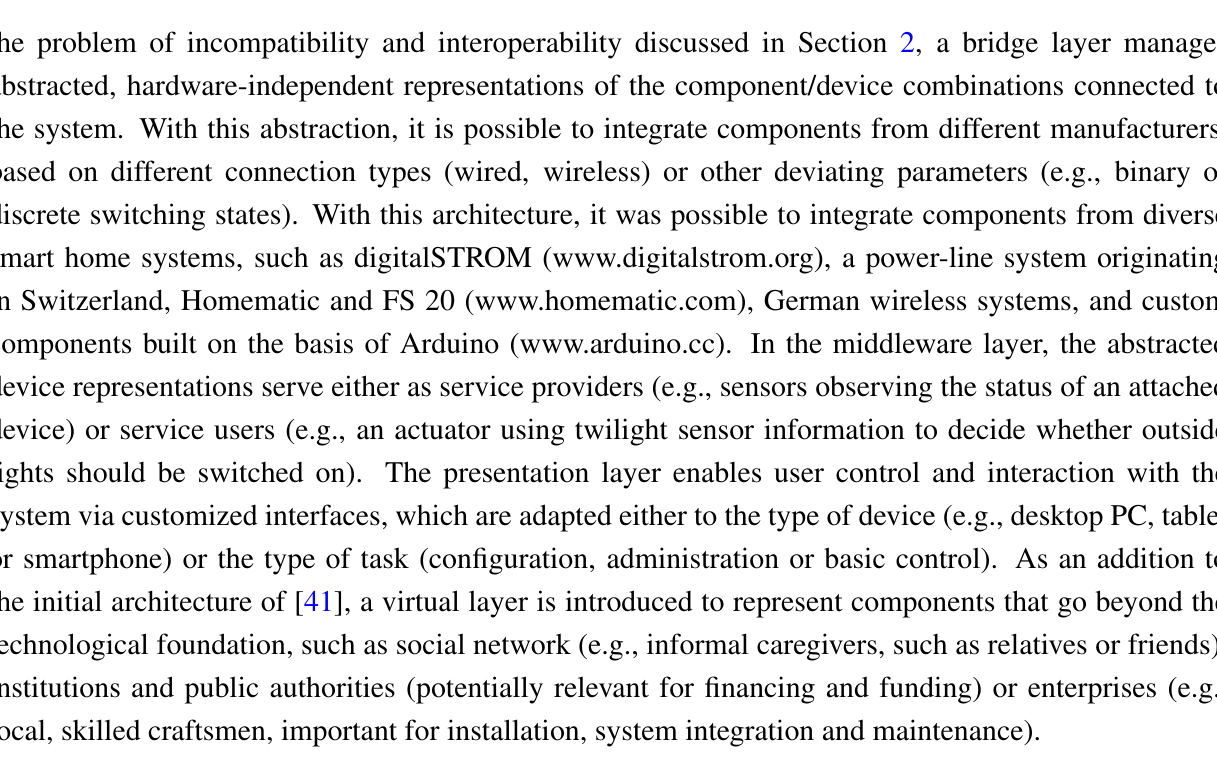
Figure 2. Layered OSGi architecture, originally developed by [41] to support the research group’s activities on a smart home, in general, and AAL, in